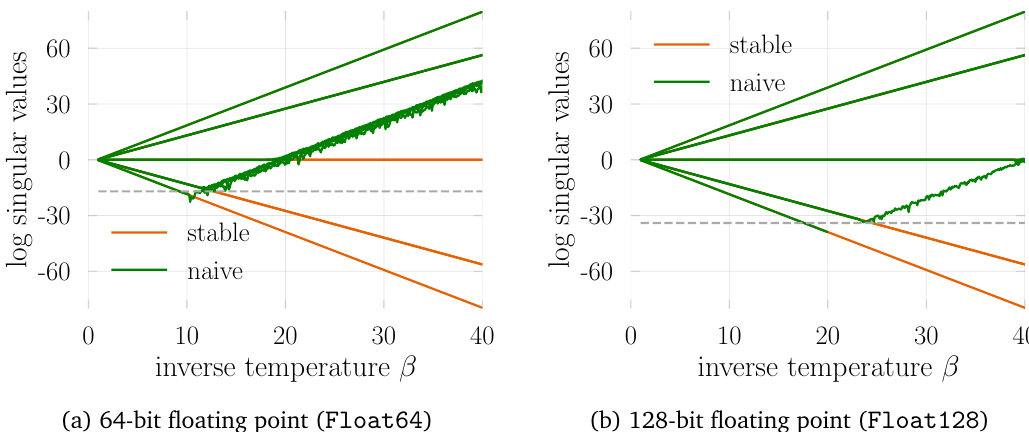
··· B B for model (7). Dif- M M − 1 1